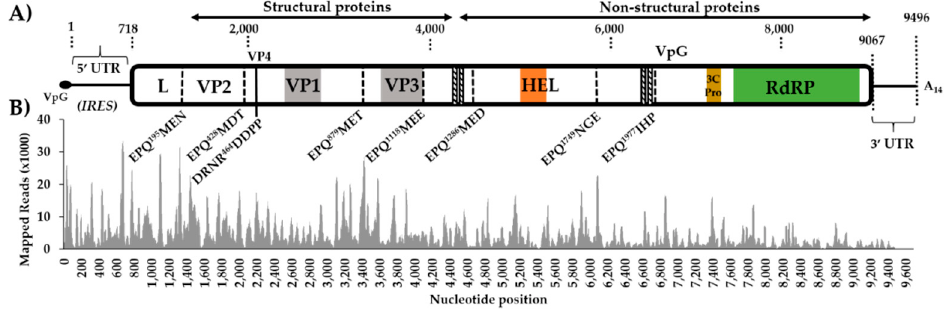
Figure 1. Genome organization of Aedes vexans iflavirus (AvIFV) and mapping coverage. ( A ) Genome organization schematic of AvIFV with dotted lines indicating conserved 3C-protease cleavage sites inferred by amino acid alignment and conserved protease consensus sites. The VP1 region corresponds to a calicivirus coat domain (PF00915), and VP3 corresponds to Cricket paralysis virus capsid (PF08762) domain. HEL corresponds to predicted RNA helicase domain (PF00910), 3C-Pro corresponds to 3C / 3C-like protease domain, and RdRP corresponds to the RNA-dependent RNA polymerase domain (PF00680). Diagonal striped lines indicate predicted transmembrane domains. internal ribosome entry site (IRES) of 5’UTR (Figure S2). ( B ) Mapping coverage of AvIFV genome 18–44 nt trimmed reads re-mapped to both genome and anti-genome orientation of the AvIFV genome.